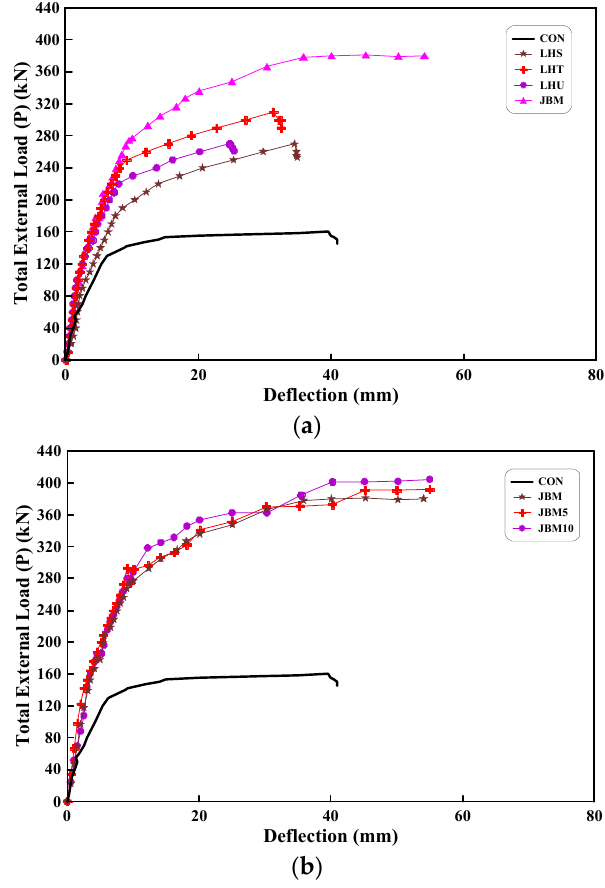
Figure 5. Load–deflection relationships of the tested beams. ( a ) Anchorage; ( b ) force in the steel rebar.